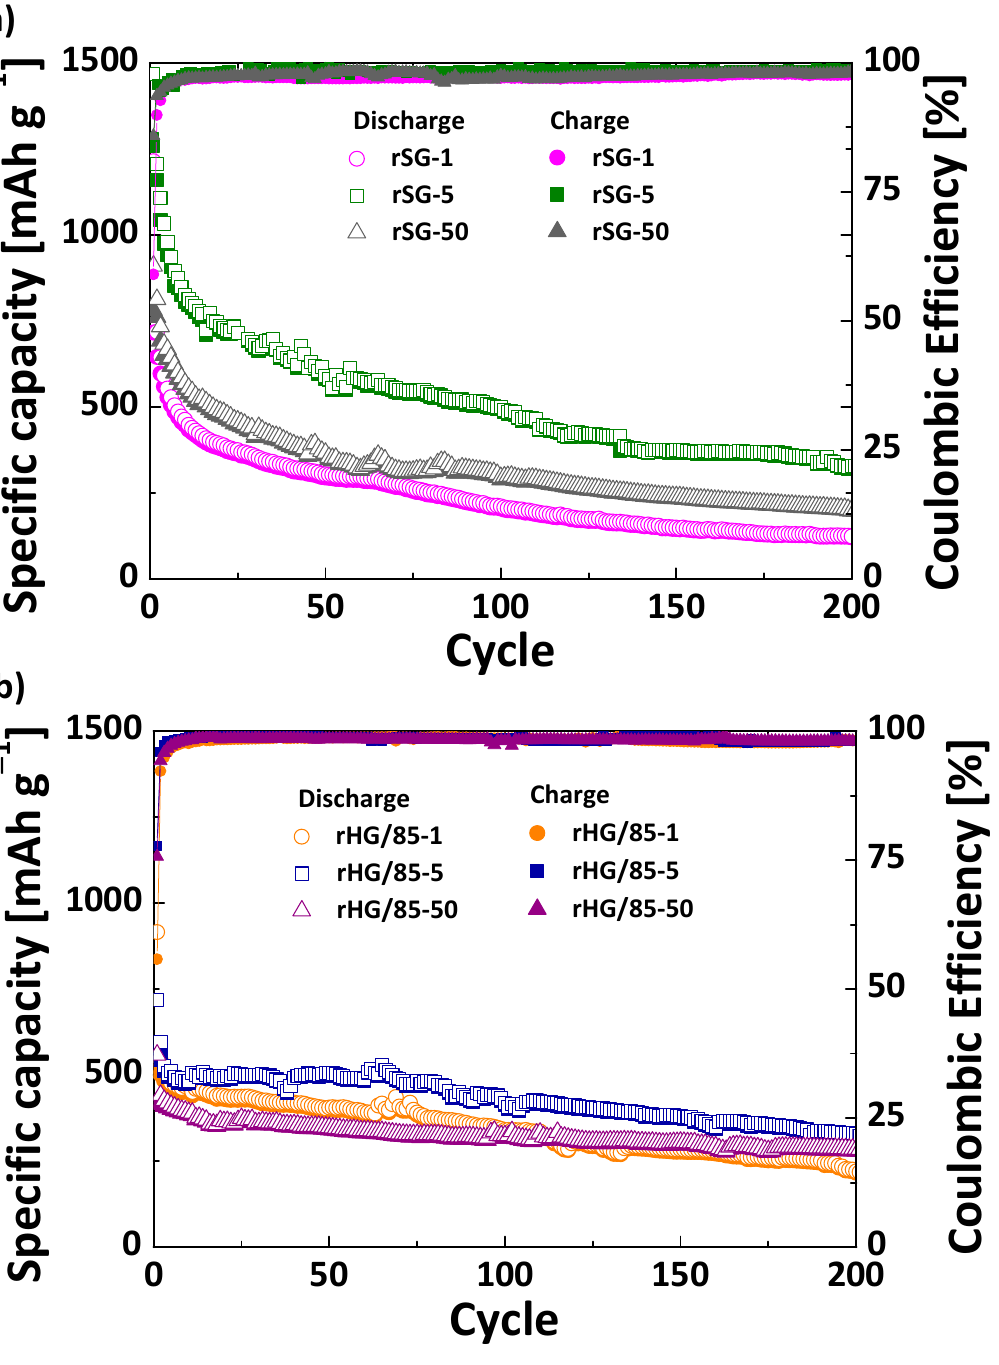
Figure 8. Specific capacity and Coulombic efficiency versus cycle number from the galvanostatic cycling at 500 mA g − 1 of rSG- ( a ) and rHG/85-based ( b ) electrode series.